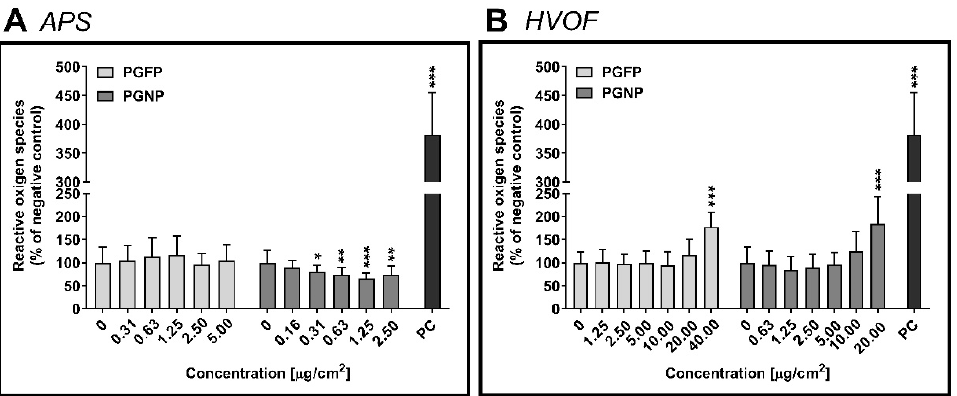
Figure 2. ROS intracellular levels in human alveolar epithelial cells after 24 h of exposure to PGFP and PGNP released during APS ( A ) and HVOF ( B ). Data are expressed as means ± standard deviations (n = 3–4). Values were normalised considering the NC. Data were analysed by the one-way ANOVA test followed by Dunnett’s post hoc test for multiple comparisons. * p ≤ 0.05, ** p ≤ 0.01 and *** p ≤ 0.001 vs. NC. PC: 25 µM AgNO 3 .